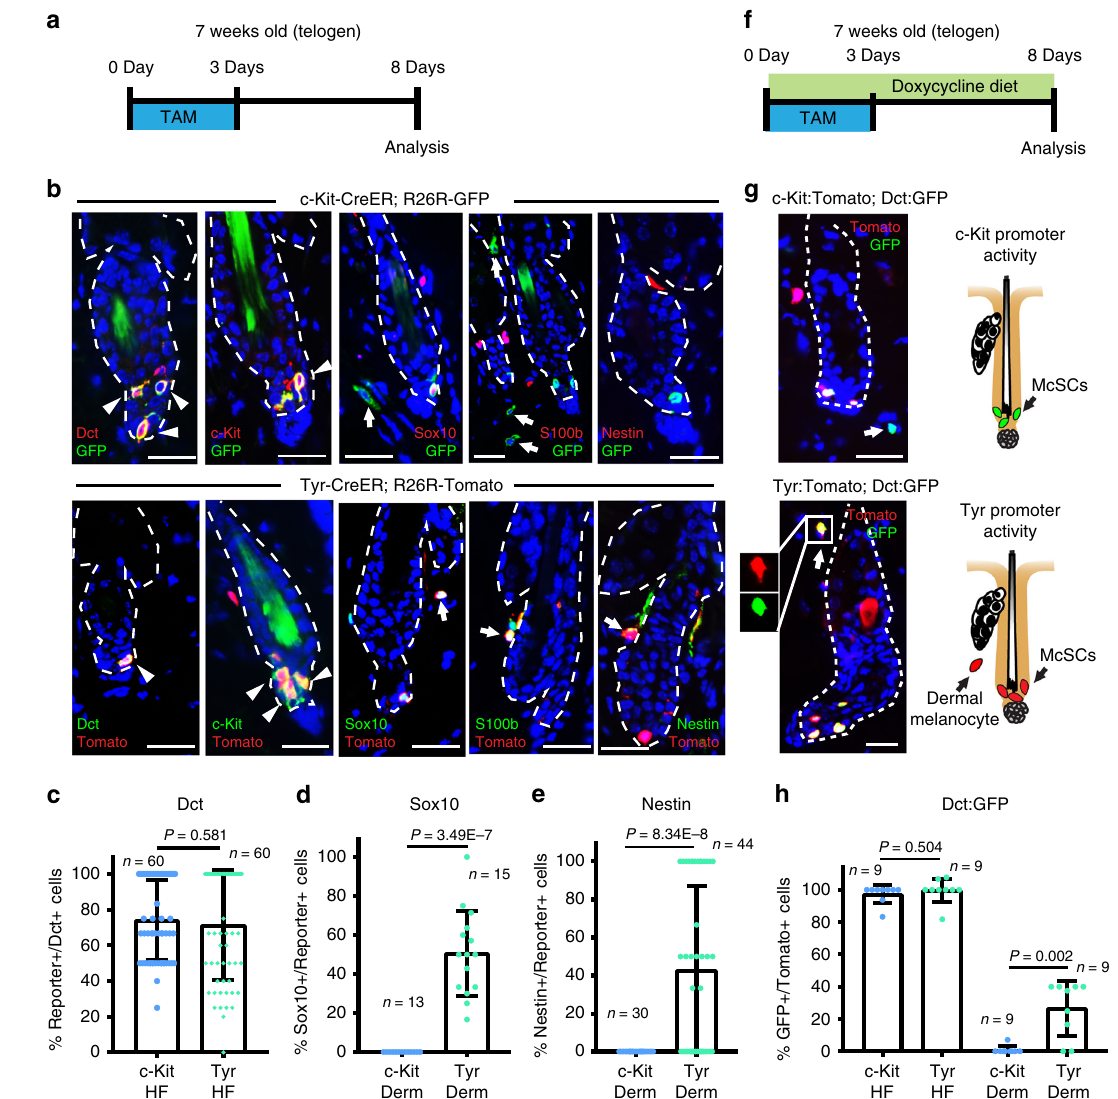
Fig. 1 C-Kit-CreER targets McSCs, while Tyr-CreER also targets dermal melanocytic cells. a Schematic shows tamoxifen (TAM) treatment and analysis regimen for b – e . b Immuno fl uorescence for GFP (green) and Dct, c-Kit, Sox10, S100b, Nestin (red) in c-Kit-CreER; R26R-GFP skin (Top panel) and Tomato (red) and Dct, c-Kit, Sox10, S100b, Nestin (green) in Tyr-CreER; R26R-Tomato skin (Bottom panel). c – e Dot plot shows percentage of reporter + cells in Dct + cells inside the HF c , Sox10 + cells in reporter + cells in the dermal compartment d and Nestin + cells in reporter + cells in the dermal compartment e (mean ± s.d.; 3 mice were analyzed in each group, n = number of hair follicles c or dermal areas d , e analyzed). f Schematic shows TAM and doxycycline (Dox) treatment and analysis regimen for g , h . g Immuno fl uorescence for GFP (green) and Tomato (red) in c-Kit-CreER; R26R-Tomato; Dct-rtTA; tetO-H2B- GFP skin (Top) and Tyr-CreER; R26R-Tomato; Dct-rtTA; tetO-H2B-GFP skin (Bottom); Schematic model showing the distribution of c-Kit and Tyr promoter active cells in right panels. h Dot plot shows percentage of GFP + cells in Tomato + cells in the HF and dermal compartment of g (mean ± s. d.; 3 mice were analyzed in each group, n = number of skin areas analyzed). Dashed line outlines the boundary of epithelium and dermis. Scale bar, 25 μ m. Arrowheads point to follicular McSCs; Arrows point to GFP + or Tomato + cells in the dermis. HF hair follicle, McSCs melanocyte stem cells, Derm dermal compartment, TAM tamoxifen. Source data are provided as a Source Data fi